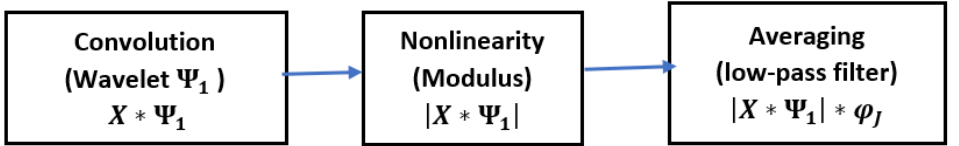
Figure 2. Wavelet scattering transform processes, where X is the input data, Ψ 1 a wavelet function and φ J an averaging low-pass